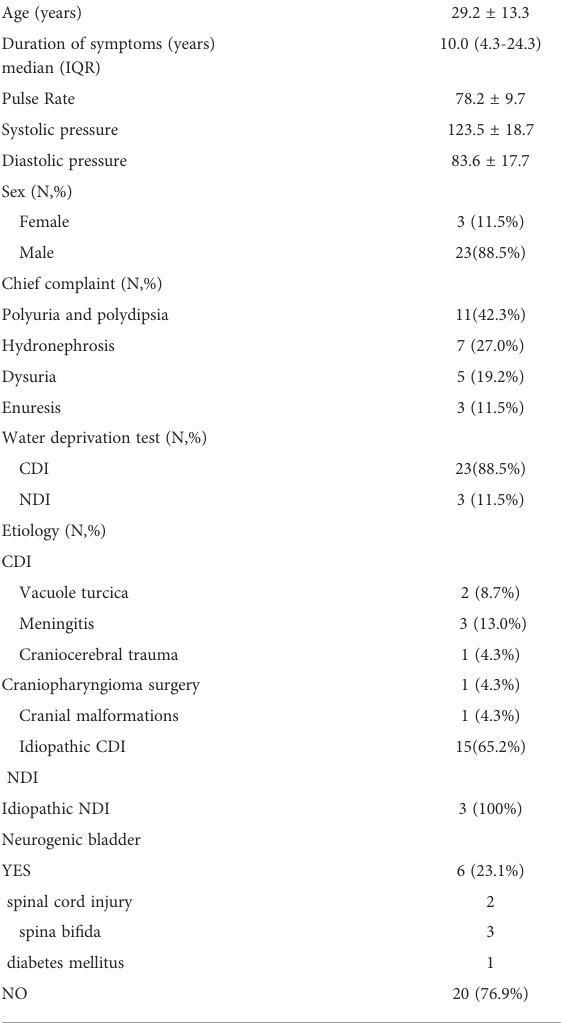
TABLE 2 The demographic and based characteristics of the primary